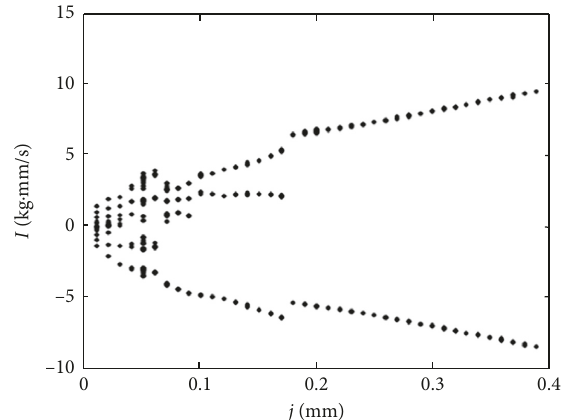
Figure 4: Bifurcation of impact